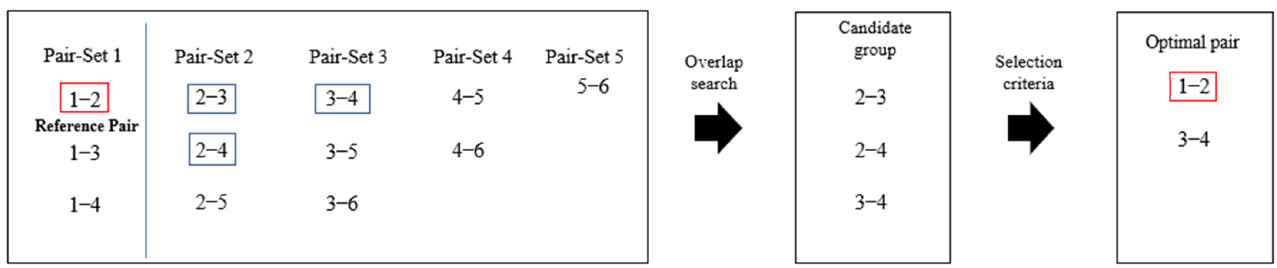
Figure 5. The first iteration for optimal pair composition in a strip .